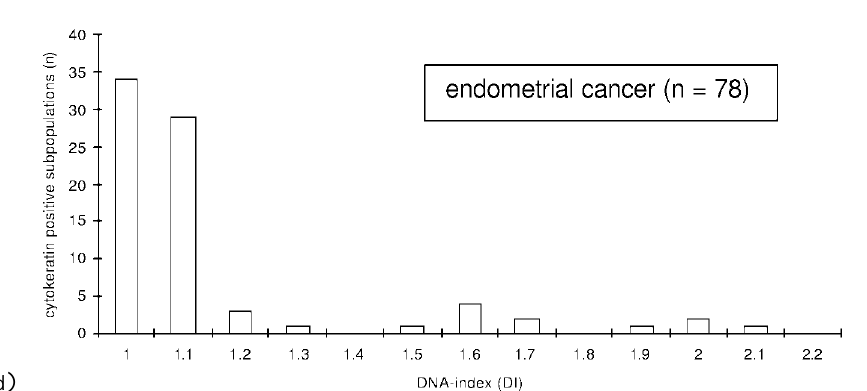
Fig. 2. DNA-index of cytokeratin positive subpopulations for carcinomas of the breast (a), ovary (b), cervix (c) and endometrium (d). The amount of DNA-aneuploid subpopulations following labeling with cytokeratin antibodies was determined in single cell suspensions. For 327 primary breast cancers the distribution of DNA-index of all DNA-aneuploid subpopulations ( n = 334) was shown together with the DNA-diploid tumors ( n = 77, DI = 1.0) (a). For 129 primary ovarian cancers distribution of DNA-index of all DNA-aneuploid subpopulations ( n = 158) was demonstrated together with the DNA-diploid tumors ( n = 29, DI = 1.0) (b). In Fig. 2c the distribution of DNA-index of all DNA-aneuploid subpopulations of 91 cervical cancers ( n = 103) was shown together with the DNA-diploid tumors ( n = 18, DI = 1.0) (c). The distribution of DNA-index of all DNA-aneuploid subpopulations of 73 primary endometrial carcinomas ( n = 44) was shown together with the exclusive DNA-diploid tumors ( n = 34, DI = 1.0)